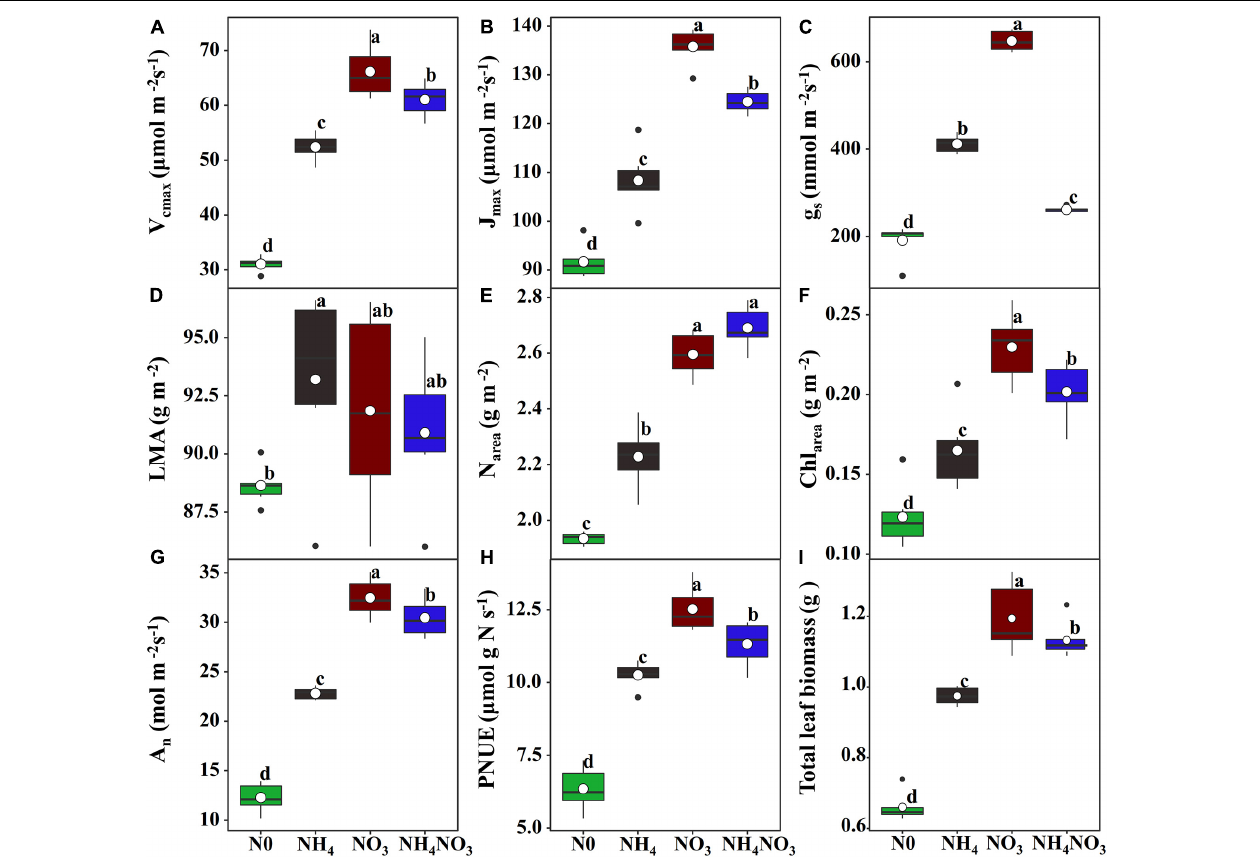
FIGURE 1 | Effect of N (N) forms treatments on maximum carboxylation rate (V cmax ) (A) , maximum photoelectron transfer rate (J max ) (B) , stomatal conductance (g s ) (C) , leaf mass area (LMA) (D) , area-based N content (N area ) (E) , area-based chlorophyll content (Chl area ) (F) , net CO 2 assimilation rate (A n ) (G) , photosynthetic N use efficiency (PNUE) (H) , and total leaf biomass (I) in L. chinensis . White dot is “Mean”; black dot is “Outlier”; horizontal is “Median”; the top of vertical line is “Max” and the bottom of vertical line is “Min.” Different lower-case letters indicate significant differences between the measuring dates under the unfertilized (N0) treatment and the fertilized (NH 4 , NO 3 , NH 4 NO 3 ) treatment, respectively ( p < 0.05) ( n =